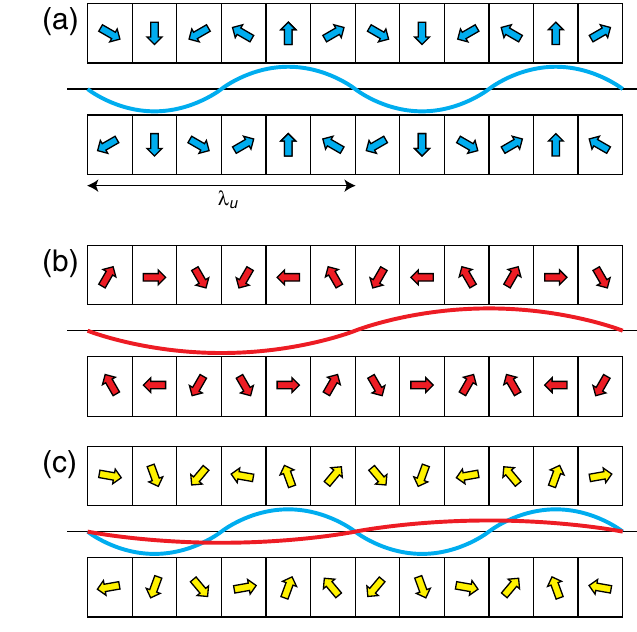
FIG. 2. As in Fig. 1 but with six blocks per period.